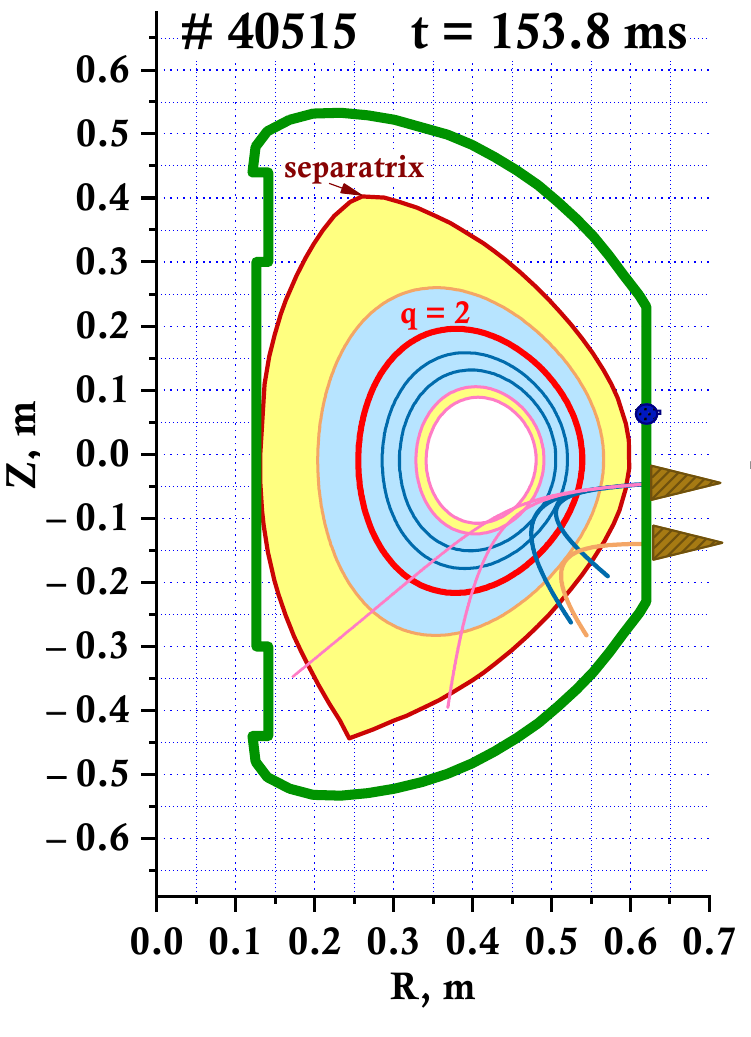
Figure 7. Poloidal cross-section of the Globus-M2 tokamak with magnetic field lines using EFIT and performed ray tracing for DBS probing waves for discharge #40515.